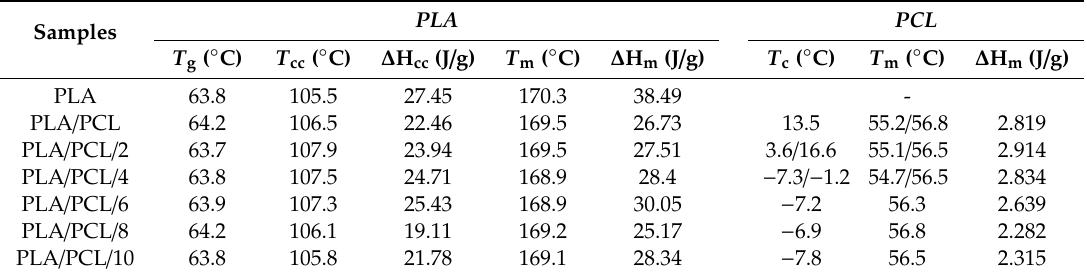
Figure 5. DSC second heating curves of the neat PLA, PLA / PCL and PLA / PCL / EMA-GMA blends. Table 2. Thermal properties of the neat PLA, PLA / PCL and PLA / PCL / EMA-GMA blends.